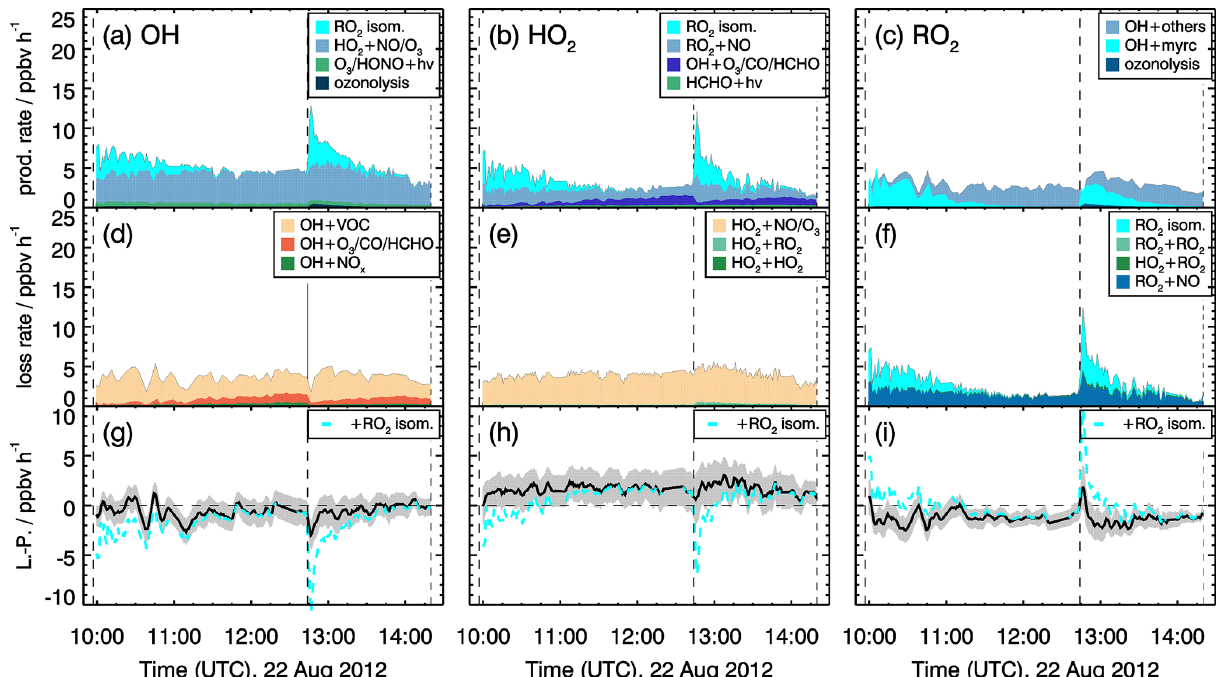
Figure 11. Rates of radical conversion reactions and imbalances between production and destruction rates ( L − P ) for the experiment with medium NO mixing ratios (0.15 to 0.30ppbv) on 22 August 2012. Grey areas in the lower panels give the uncertainty of the calculation ( L − P ). In the bottom row, the black and cyan lines denote the radical budget with and without considering MyO 2 isomerization reactions. Upper limits for yields of OH and HO 2 radicals from MyO 2 isomerization reactions of one are assumed in the calculations of their production